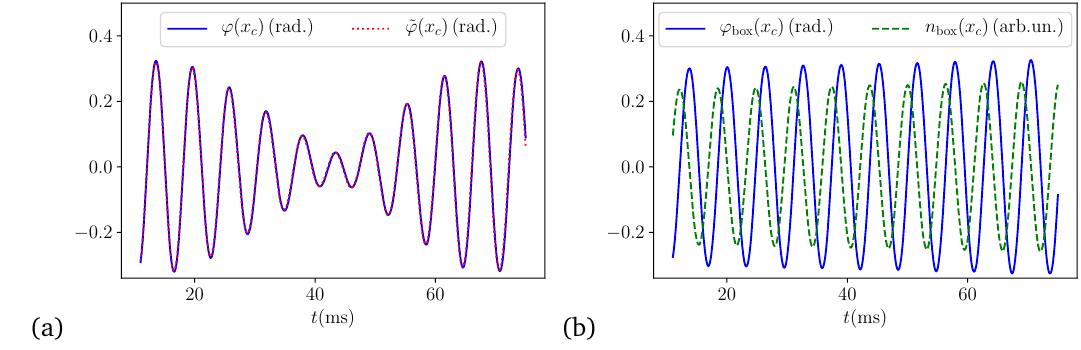
Figure 14: (a) the same curve as the phase ϕ from Fig. 11(a), presented alongside = 0 for all permutations of indices. (b) the same quantity, but computed with Γ 2 jkl oscillations of relative density n and phase ϕ for the same parameters as Fig. 11(a) but in a hard-wall box potential of size L = 80 µ m. The bulk density is chosen to match the peak density from the initial condition of Fig.